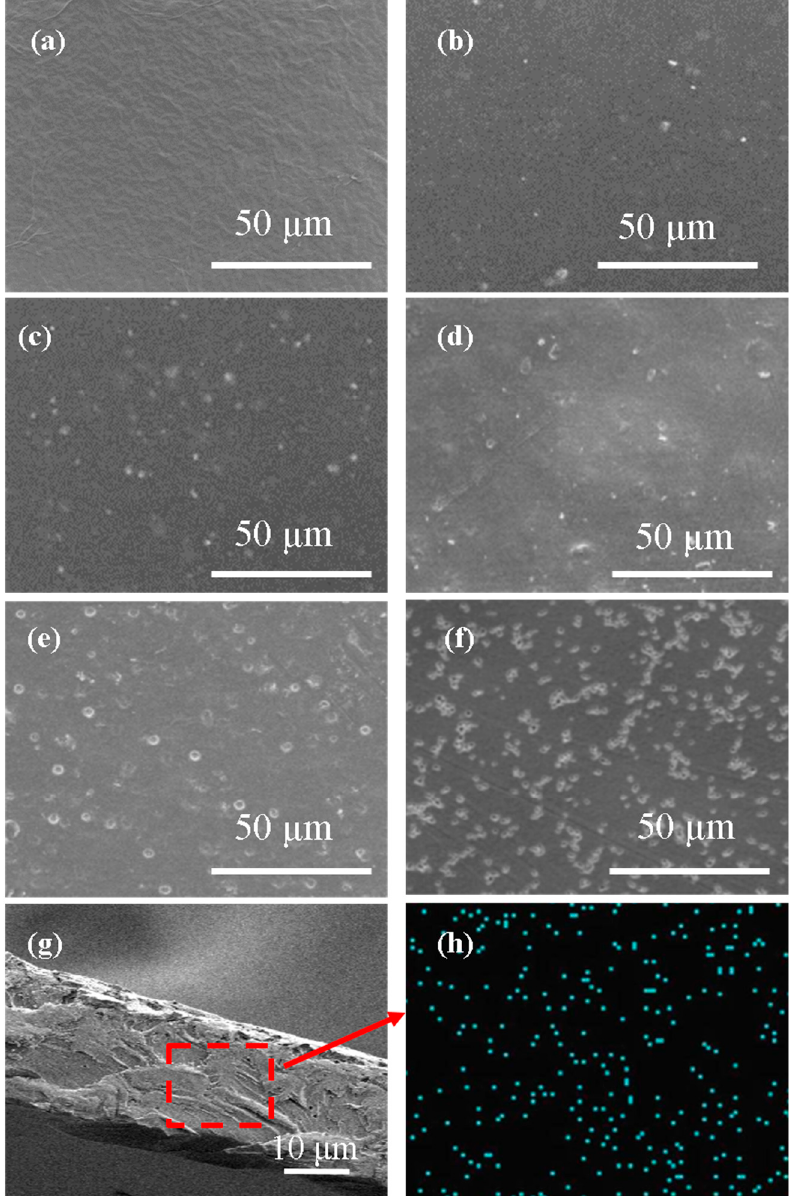
Figure 4. SEM images of the mixed matrix membranes (membrane surface of ( a ) M-0, ( b ) M-5, ( c ) M-10, ( d ) M-15, ( e ) M-20, ( f ) M-25, ( g ) M-20 cross-section and ( h ) Co EDS mapping).